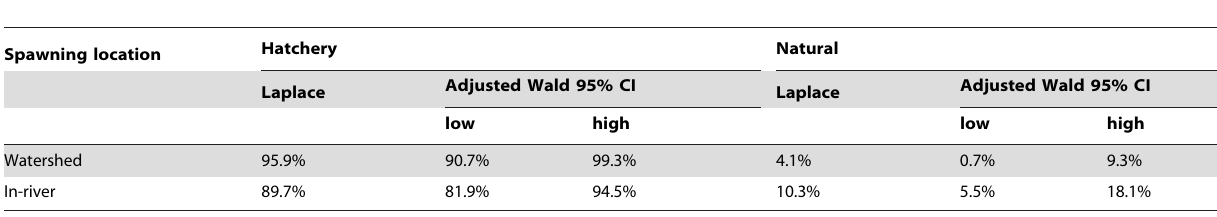
Table 1. Estimate of hatchery and natural-origin